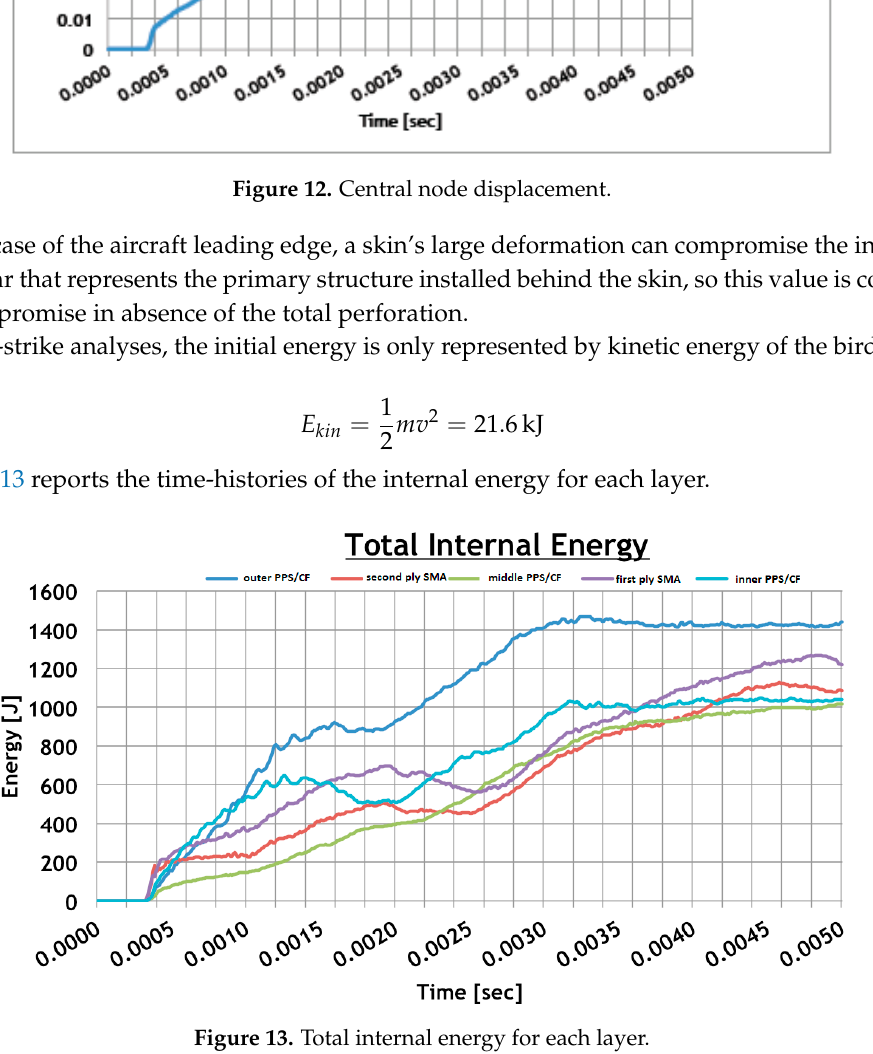
Figure 12. Central node displacement.